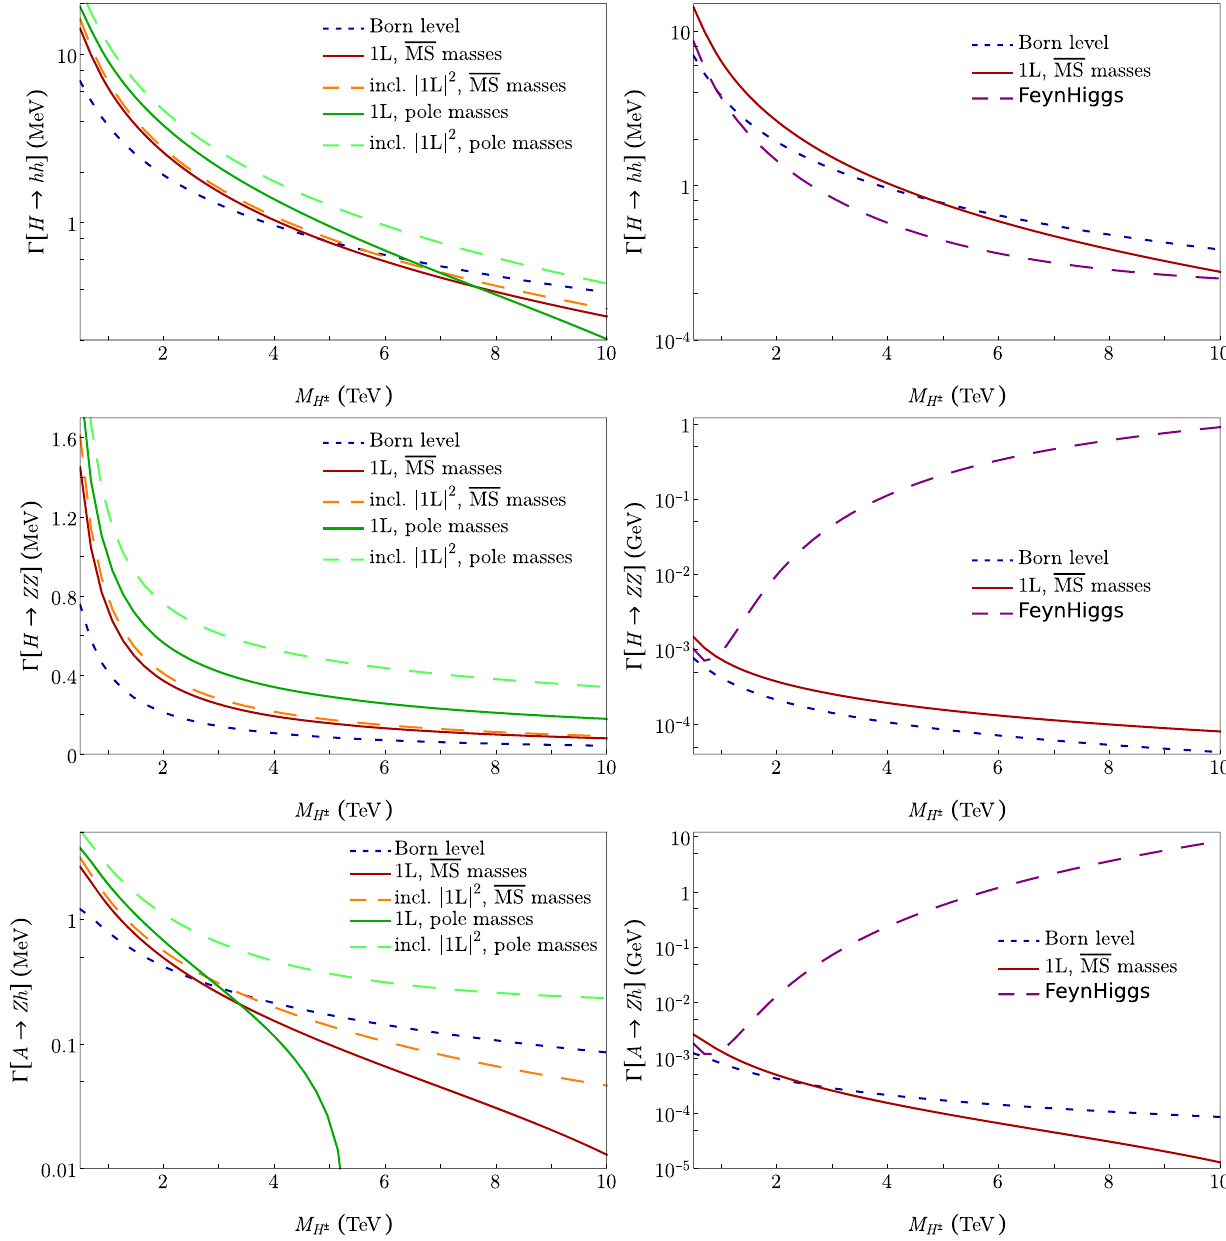
Fig. 1 Bosonic two-body decay widths as a function of the heavy Higgs scale in the MSSM at t β = 10: (cid:6) [ H → hh ] , (cid:6) [ H → Z Z ] and (cid:6) [ A → Zh ] are displayed in the first, second and third row, respec- tively. Left: the born-level amplitude is shown in short-dashed blue, the strict 1L amplitude in solid lines, while the long-dashed curves include